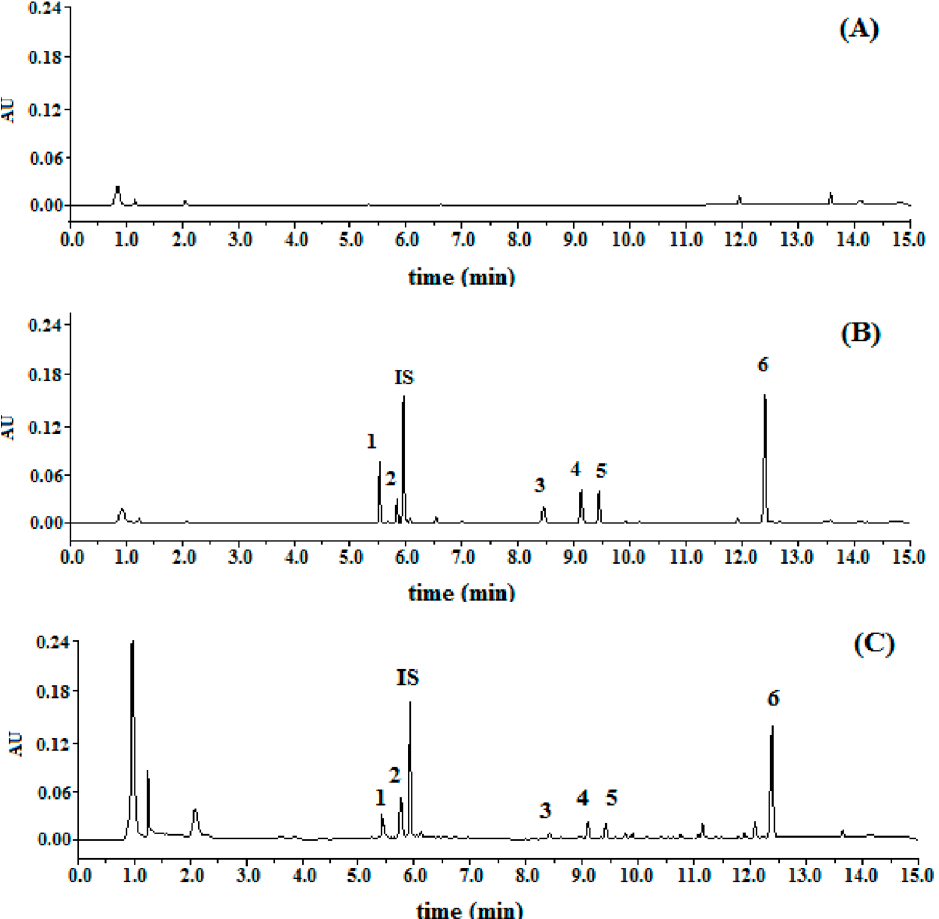
Figure 2. The representative UPLC-UV chromatograms. ( A ) Blank outflow of intestinal perfusate; ( B ) intestinal perfusate matrix spiked with C1, C2, C3, C4, DC1, DC2, and IS; ( C ) the intestinal outflow perfusate collected at 20–30 min after in situ single-pass perfusion with MDQ-TS contained K-R buffer. The potential interference of intestinal perfusate endogenous with the analytes was assessed by comparing the chromatograms of the above processed intestinal perfusion samples.